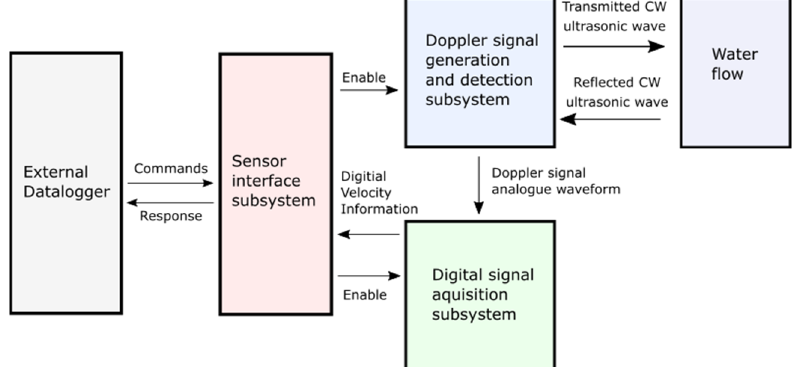
Figure 2. Functional block diagram of major sensor subsystems. Interaction between subsystems displayed on arrows. The sensor consists of the Doppler signal generation and detection subsystem (see Section 2.1.1), digital signal acquisition subsystem (see Section 2.1.2), and sensor interface subsystem (see Section 2.1.3). The sensor interacts with the water via the ultrasonic transducers and is connected to the external datalogger via electrical cable.